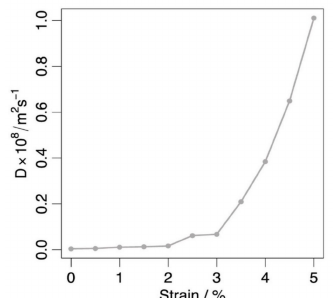
Figure 4. The molecular dynamics derived oxygen diffusivity with respect to uniaxial stain in undoped ceria